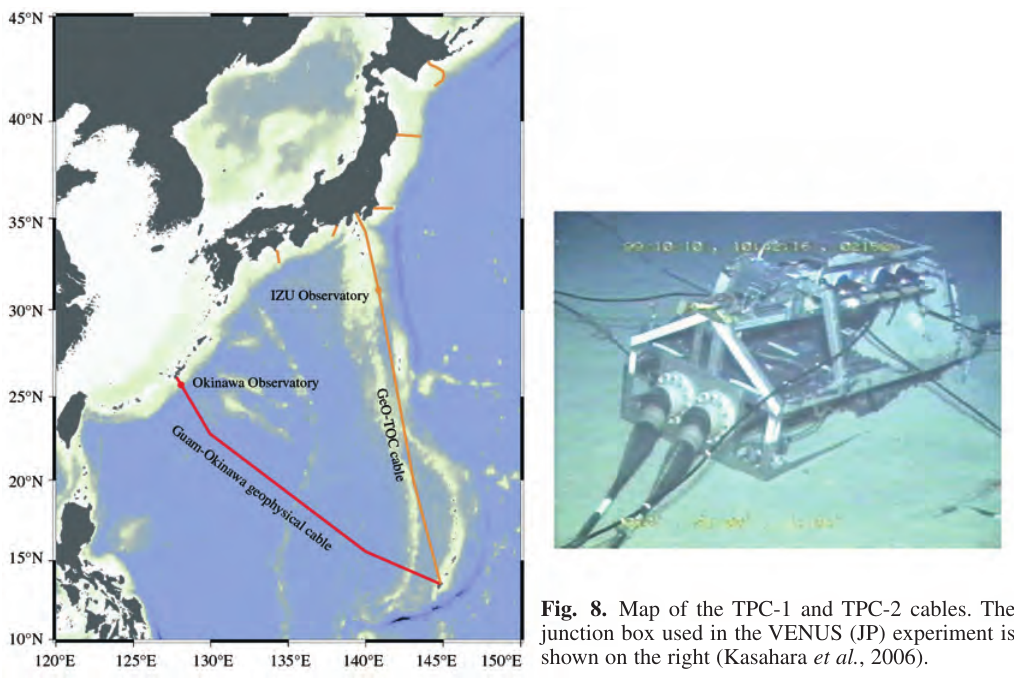
Fig. 8. Map of the TPC-1 and TPC-2 cables. The junction box used in the VENUS (JP) experiment is shown on the right (Kasahara et al. ,